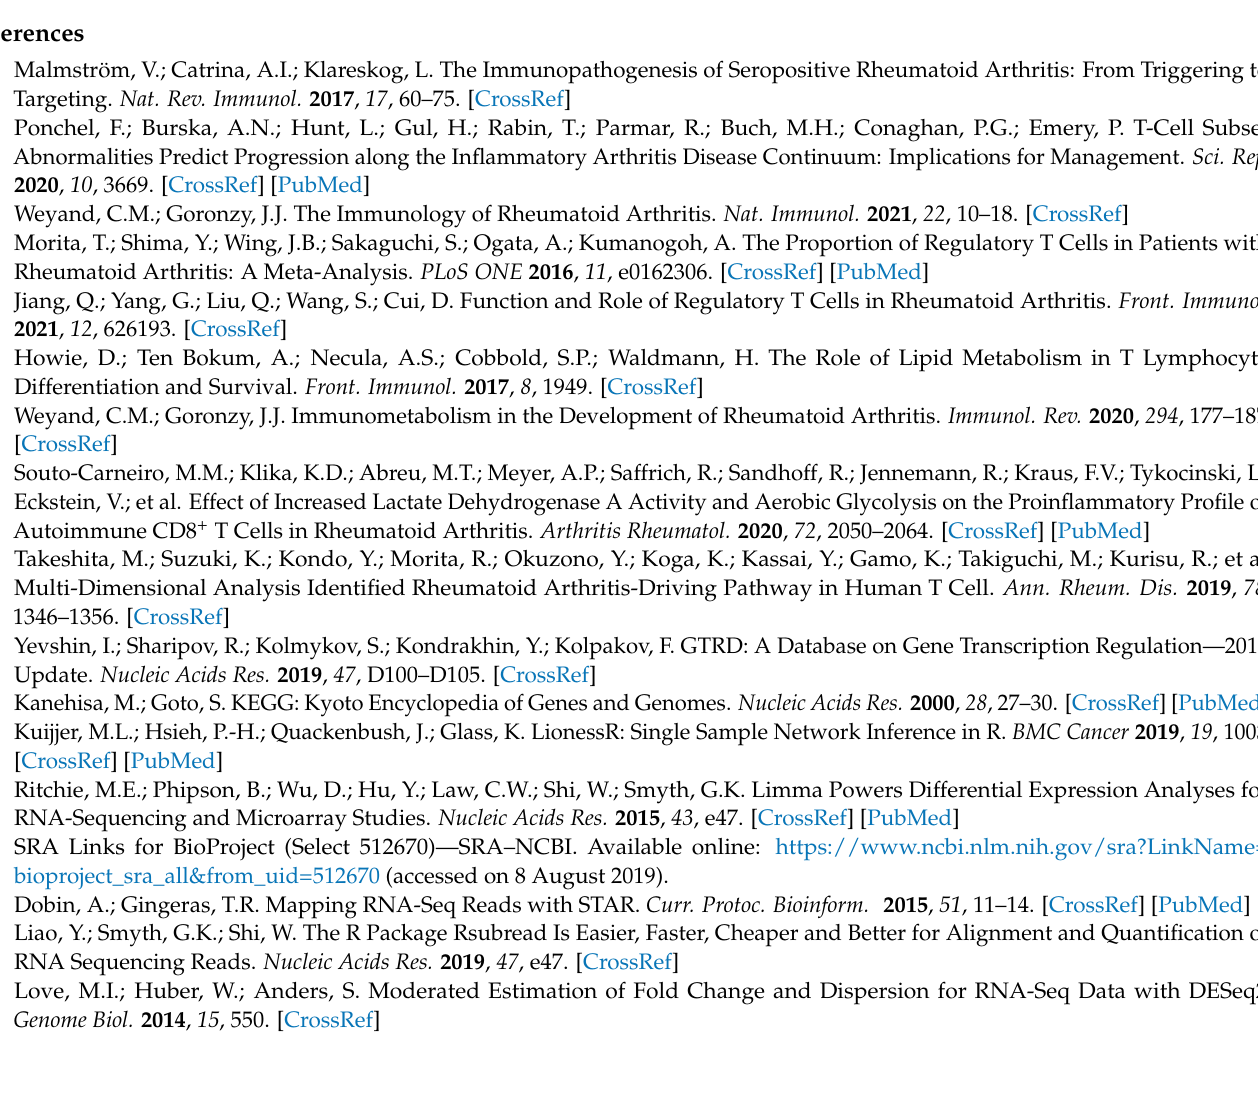
cells. Figure S12. Normalized counts of oxidative phosphorylation complex 45 genes in untreated RA CD8 + Tem cells or in untreated RA CD8 + Temra